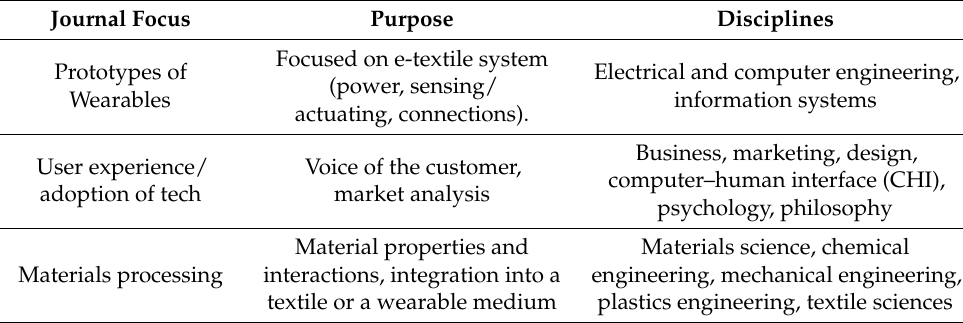
Table 5. Smart textile research publication by disciplines. Journal Focus Purpose